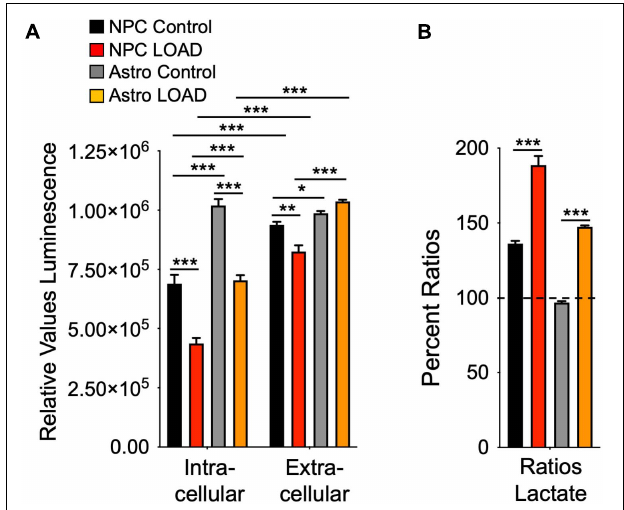
FIGURE 7 | Lactate production in iPSC-derived NPCs and astrocytes. Intracellular and extracellular (media) lactate levels were measured on LOAD ( n = 9) and Control ( n = 9) NPCs and astrocytes sand plotted as relative values luminescence (A) , or as percent ratios of extracellular to intracellular lactate (B) . Data are means +/– SEM from duplicate experiments. * p < 0.1; ** p < 0.05; *** p < 0.01 using one-way